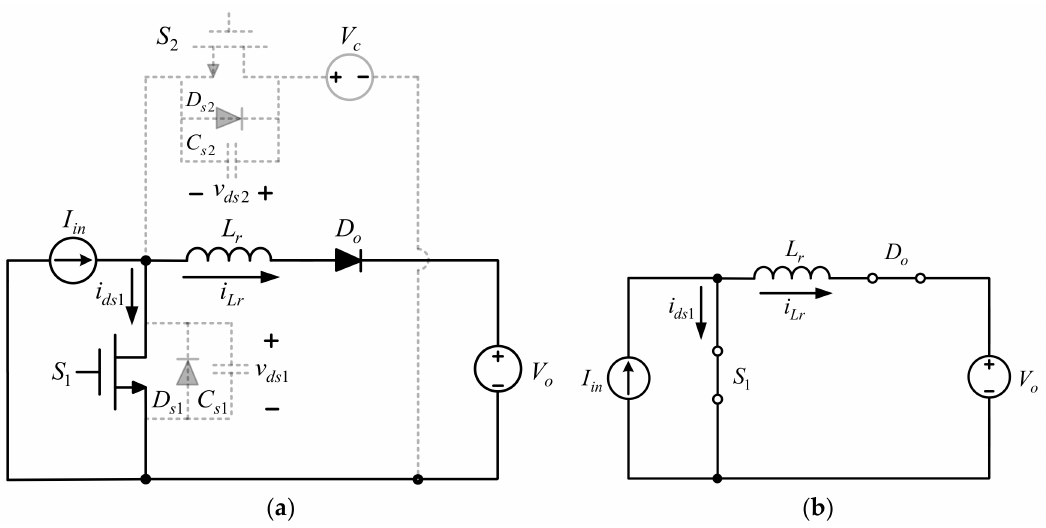
Figure 12. ( a ) Current path for stage 9; ( b ) equivalent of ( a ).